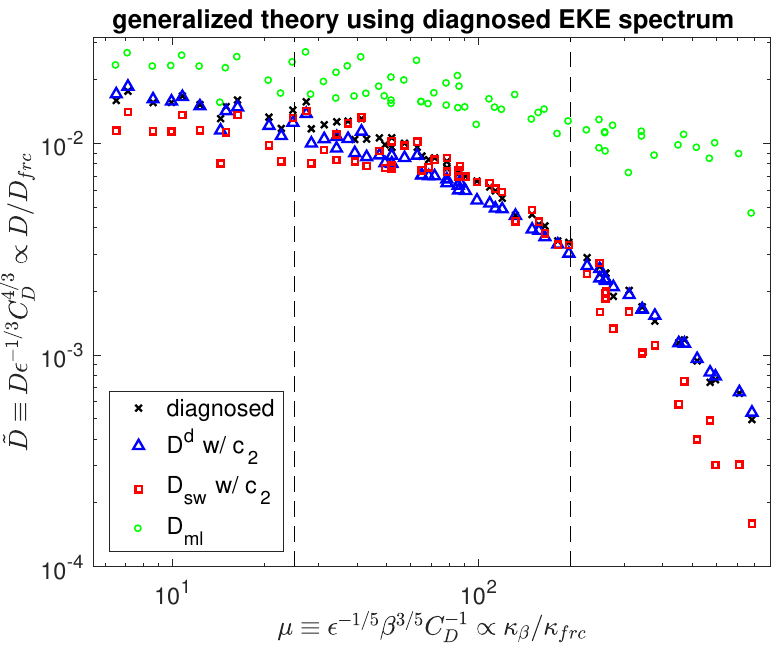
Figure 5. As Figure 3, but showing the generalized theory for the eddy diffusivity using the diagnosed eddy kinetic energy (EKE) spectrum ( D d ), the “unsuppressed” mixing length theory( D ml ), as well as the single wavenumber theory based on FN10/NGFP ( D sw ). The vertical black dashed lines are the same regime boundaries as in Figures 2 and